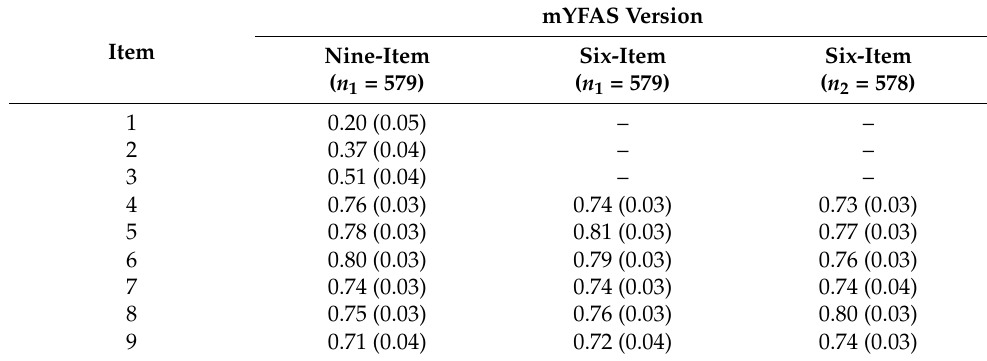
Table 2. Standardized item factor loadings and standard errors (in parentheses) for all models.